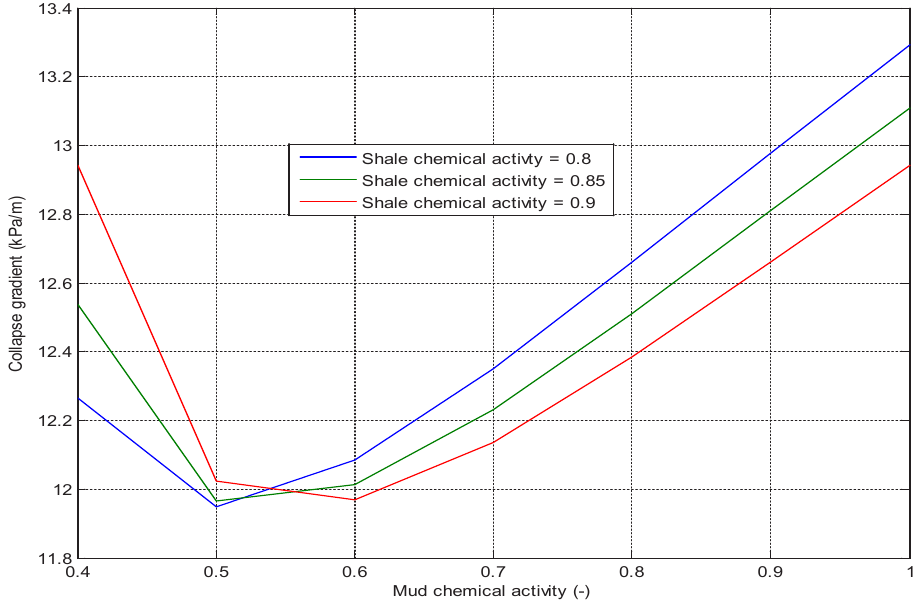
Figure 4: Effect of mud chemical activity on the collapse gradient for different shale chemical